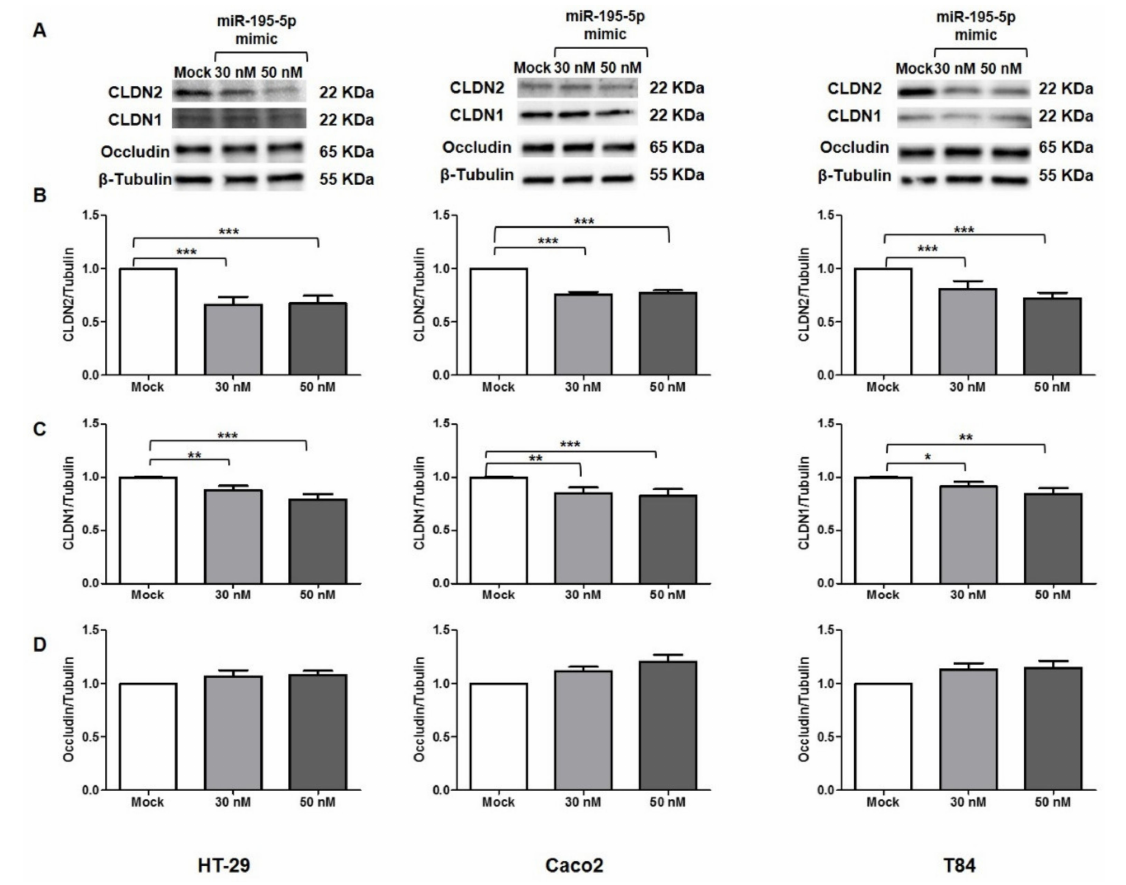
Figure 2. miR-195-5p modulates TJ protein expression after TNF- α stimulation. ( A ) Protein expression of CLDN2, CLDN1 and Occludin following TNF- α stimulation (48 h) in HT-29, Caco2 and T84 cell lines after miR-195-5p mimic transfection. Western blot quantification of CLDN2 ( B ), CLDN1 ( C ) and Occludin ( D ) protein expression in HT-29, Caco2 and T84 cell lines following TNF- α stimulation and after miR-195-5p mimic transfection. A significant reduction of CLDN2 and CLDN1 expression was detected in all cell lines. Occludin protein expression was slightly increased, even if not statistically significantly. Data were obtained by dividing the normalized transfected sample values by the normalized mock-control sample values. β -Tubulin was used as housekeeping protein to normalize the data. Raw data of the independent experiments of Western blot were reported in Appendix A. Data are representative of four independent experiments. The histograms correspond to mean ± SEM. * p < 0.05; ** p < 0.01; *** p <